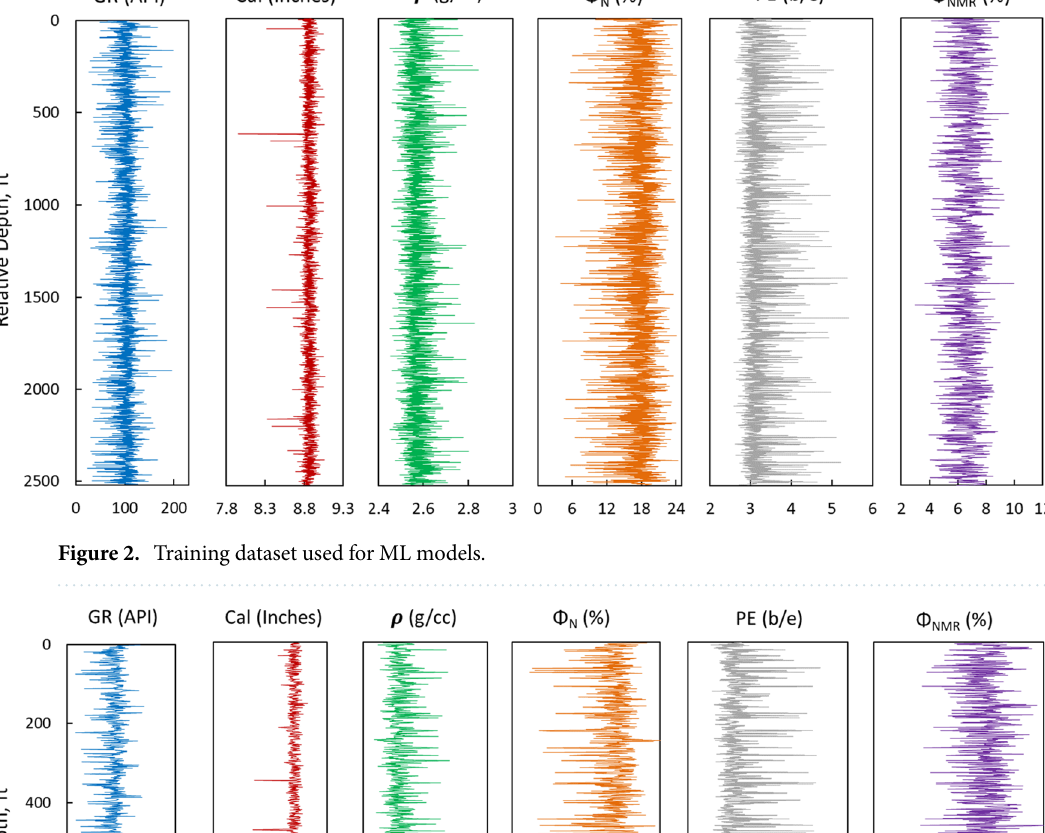
Figure 2. Training dataset used for ML models.